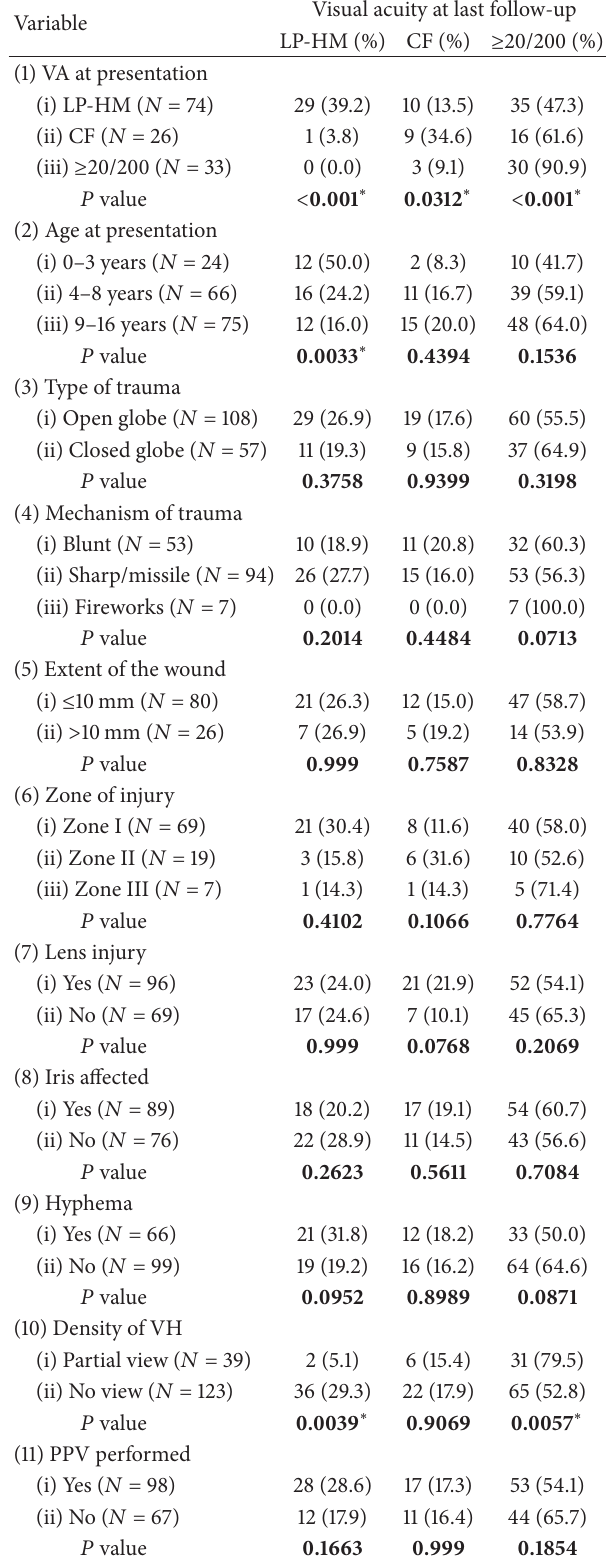
Table 6: Factors predicting visual acuity at last follow-up for eyes with nontraumatic vitreous hemorrhage. Vision was available in 33 out of 42 eyes.